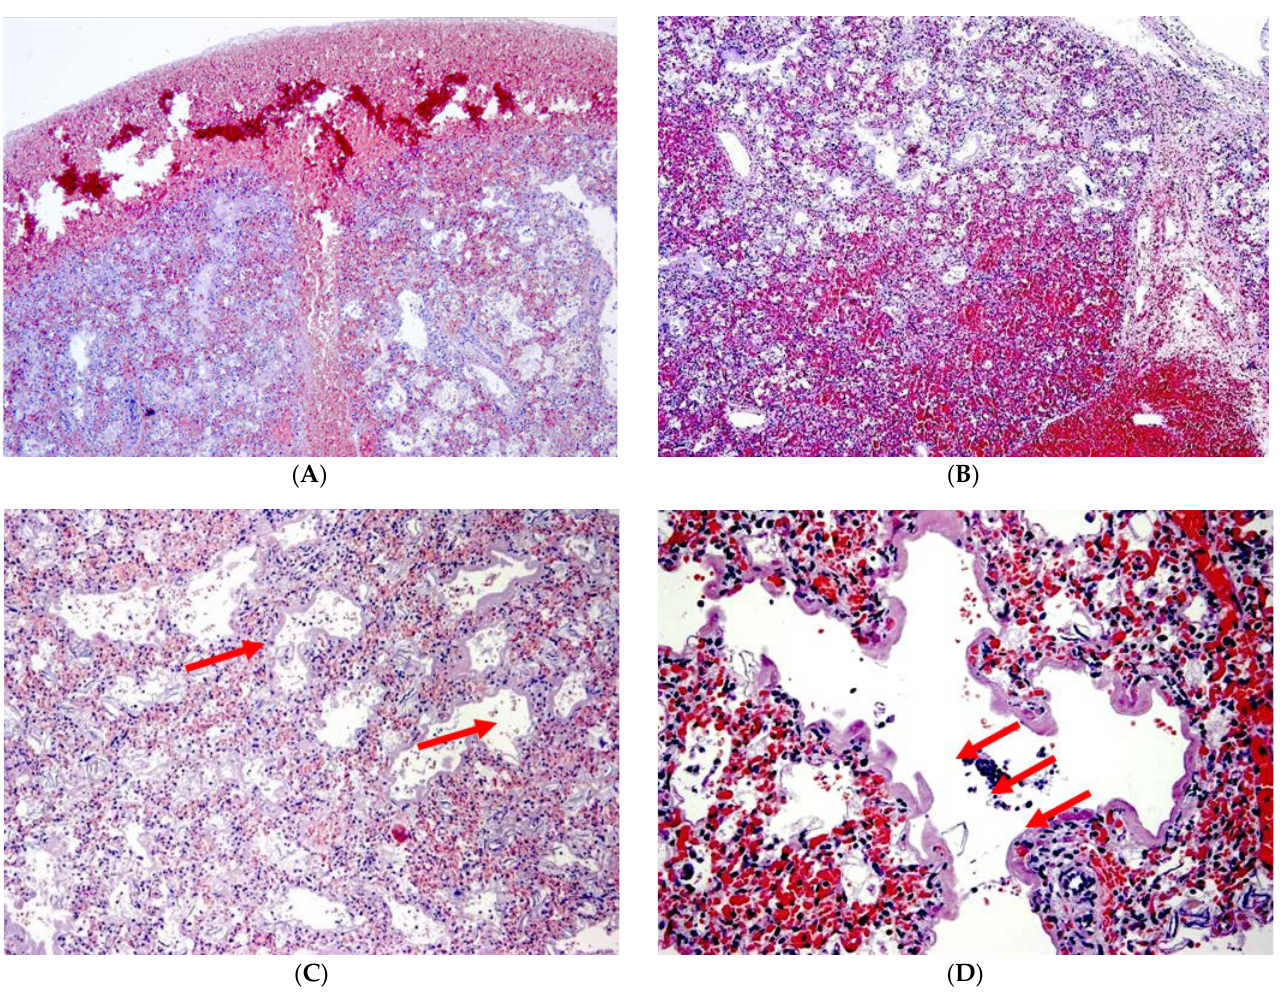
Figure 1. ( A ) The sample showed normal thickness of the pleura with red blood cells in the inter- stitium; ( B ) subpleural and alveolar hemorrhages. ( C , D ) The morphology of the pulmonary paren- chyma appeared altered by septal and interalveolar hemorrhage with the presence of hyaline mem- branes. The arrows indicate hyaline membranes covering the alveolar lumen. ( A : 4×; B : 2.5×; C : 20×; D : 20×).